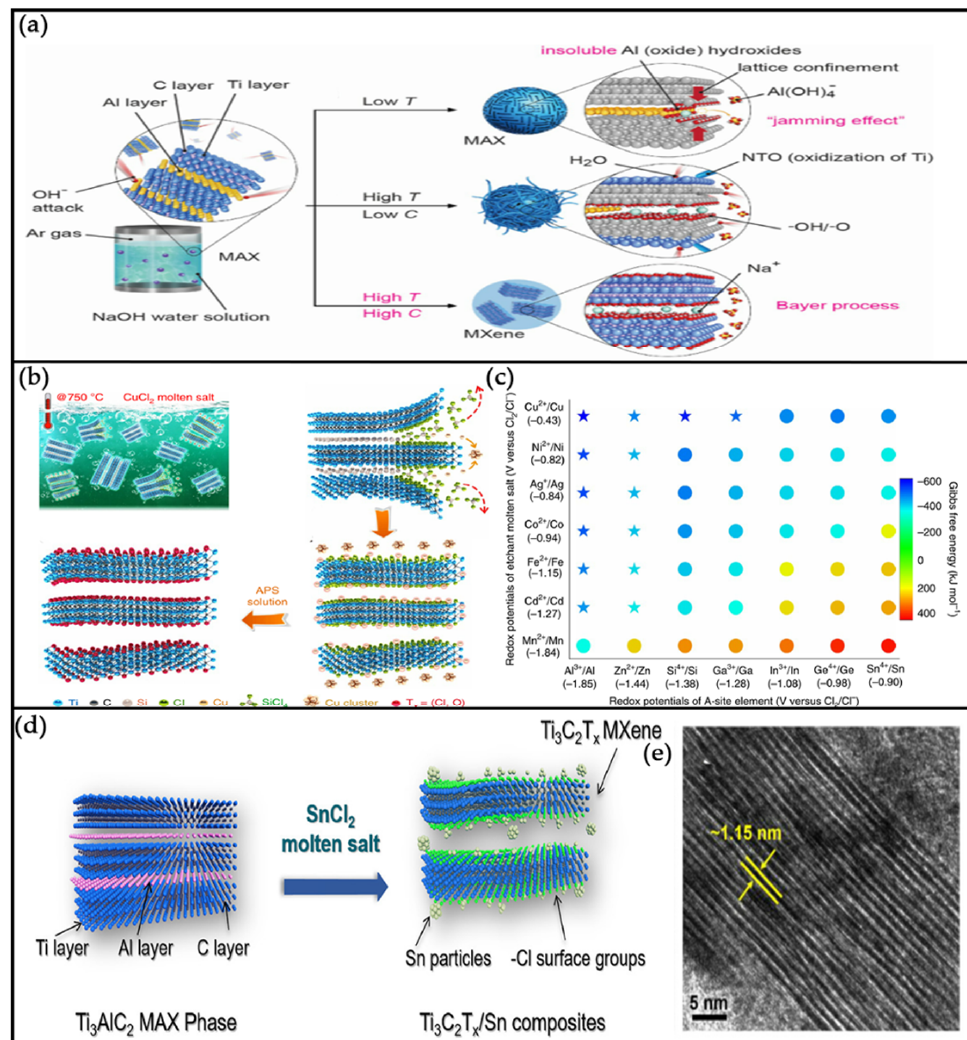
Figure 2. ( a ) The reaction between Ti 3 AlC 2 and NaOH water solution under different conditions. Reprinted with permission from Ref. [91]. Copyright 2018 WILEY-VCH. ( b ) Schematic of Ti 3 C 2 T x MXene preparation. ( c ) Generalization of the Lewis acid etching route to a large family of